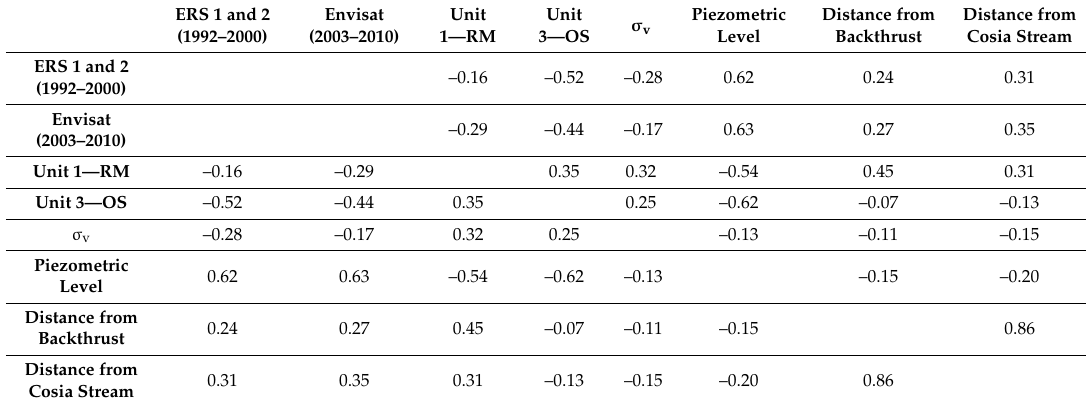
Table A1. Correlation matrix of all variables considered in this paper.